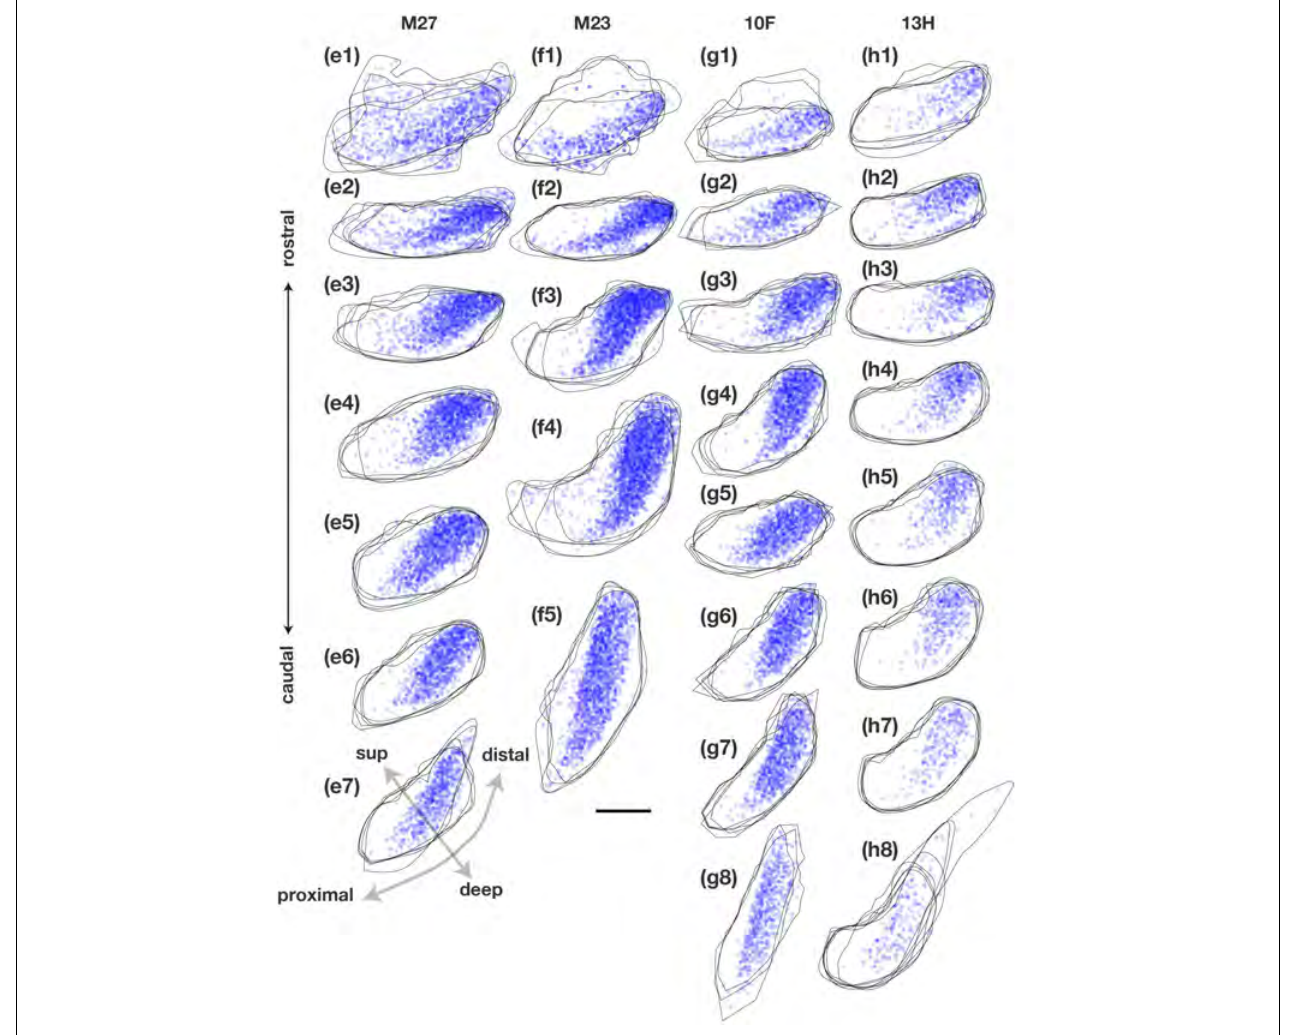
FIGURE 5 | Distribution and density of retrogradely labeled cells in the pyramidal cell layer of Sub on the ipsilateral side of the CTB injection site in each case. Plots of labeled subicular cells with the contour of Sub of five sections (about 1 mm) are superimposed and arranged in a row along the rostrocaudal axis in each case. Pale blue dots represent single retrogradely labeled cells and when they overlap (i.e., the density of labeled cells is increased), the color becomes darker. Injection sites and their diffusion are indicated by dark blue portions and plotting of the labeled cells was partially difficult within these regions. sup, superficial. Scale bar = 500 µ m. In most cases, labeled cells were densely localized in the middle superficial-to-deep part of the distal half of Sub at all levels throughout the rostrocaudal axis. In case M25, which injection site included Sub, labeled cells were concentrated also in the proximal-superficial part of